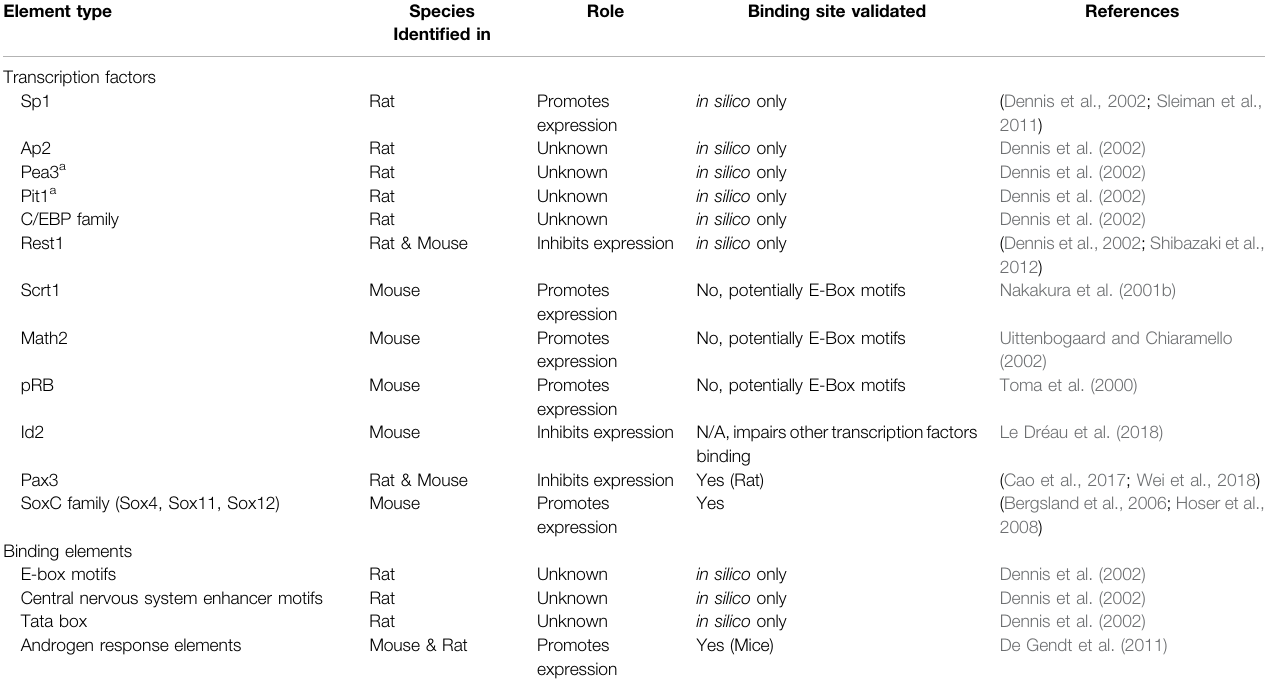
TABLE 3 | Transcription factors and Genomic elements associated with Tubb3 expression in Mice and Rats. Element